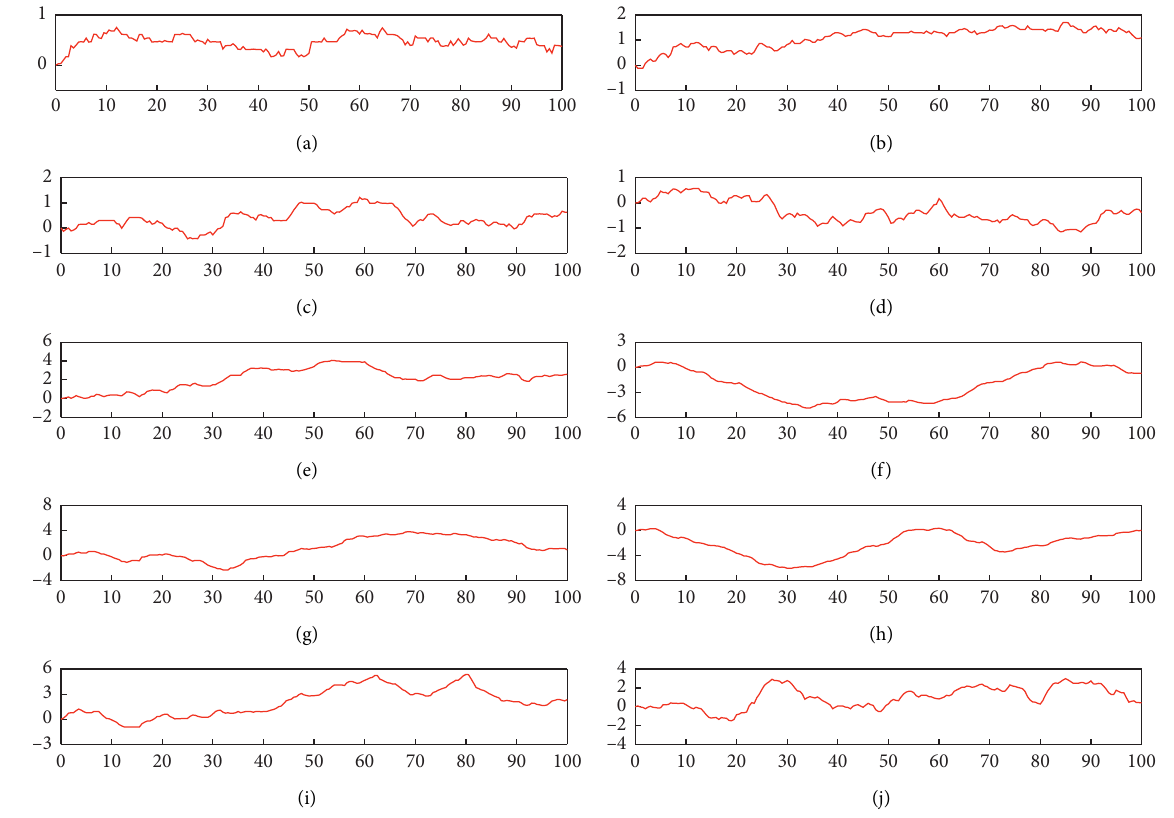
Figure 5: The modified 10 standard roughness profiles (unit: mm). (a) Profile 1. (b) Profile 2. (c) Profile 3. (d) Profile 4. (e) Profile 5.